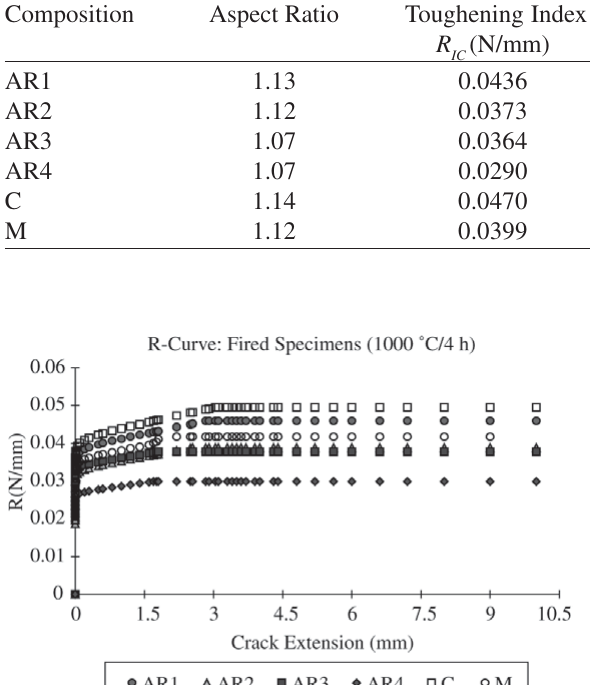
for each aggregate aspect ratio IC